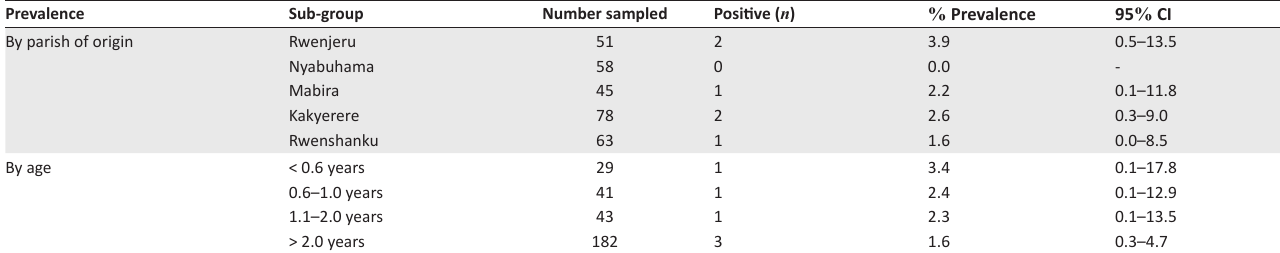
TABLE 2: Distribution of trypanosome infections by age and parish of origin.